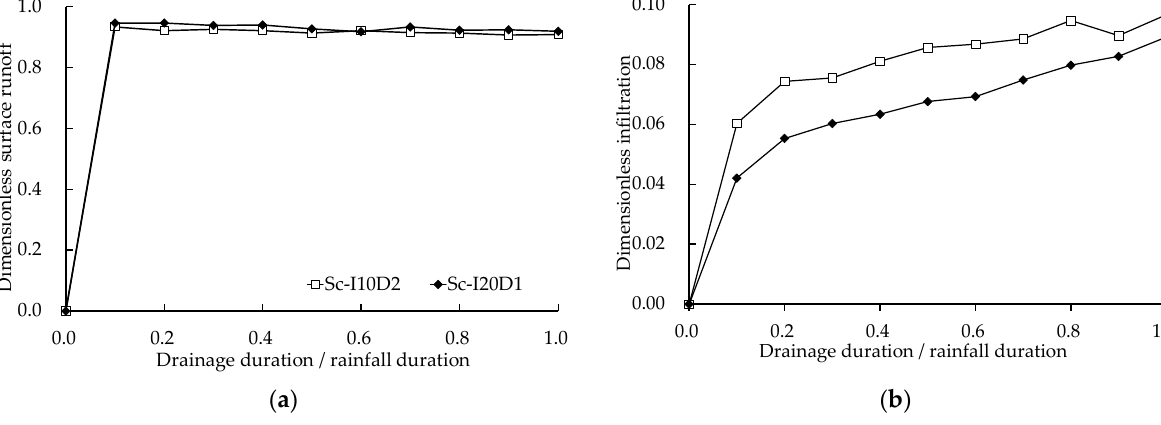
Figure 14. Scaled model simulation with rainfall depth 5.56 mm: ( a ) dimensionless surface runoff; ( b ) dimensionless infil- tration.